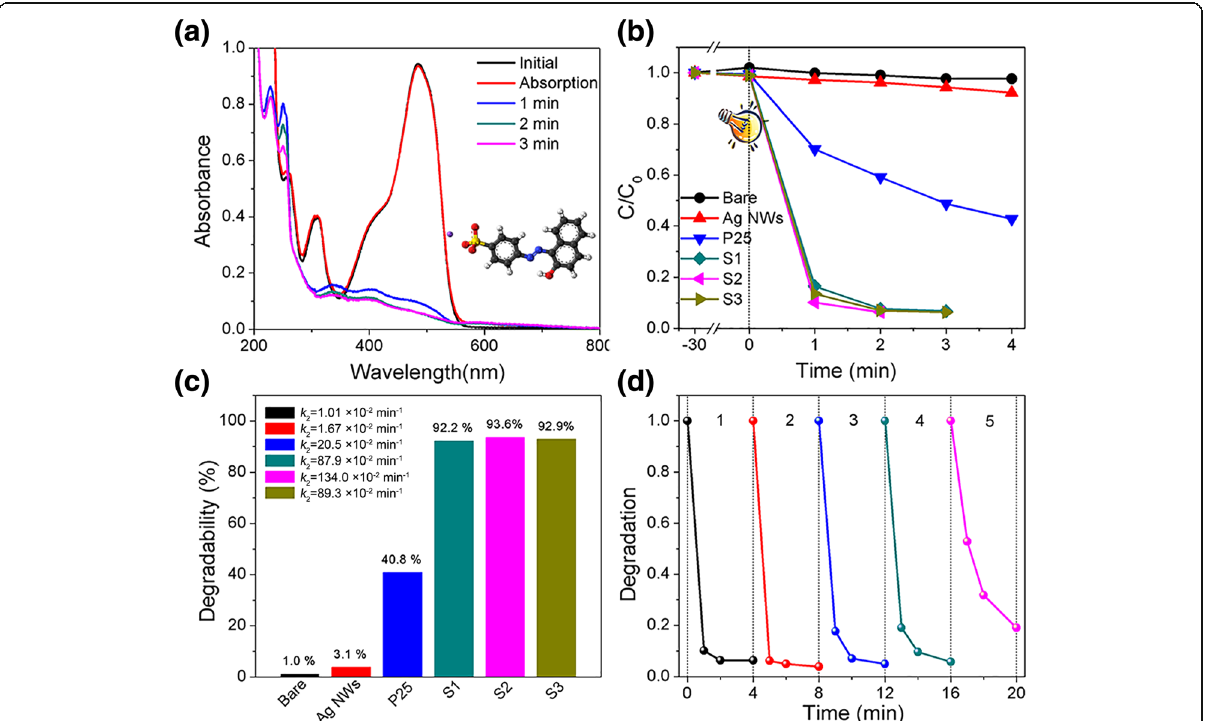
Fig. 8 a Time-dependent UV-vis spectrum of AO7 with the presence of S2 (inset is 3D molecular formulas of AO7). b Normalized concentration change of AO7 with 3 mg of as-prepared samples. c The degradability of AO7 with as-prepared samples after light illumination for 2 min. d The recycled photodegrading of the AO7 over the S2 for five